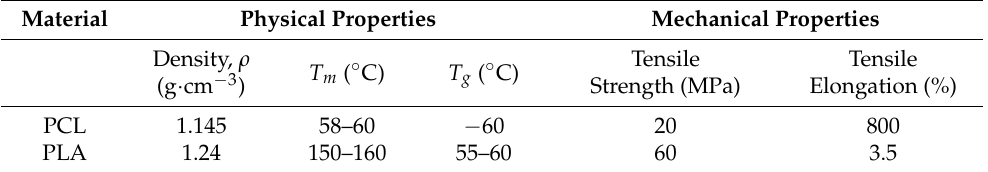
Table 1. Properties of PCL and PLA.